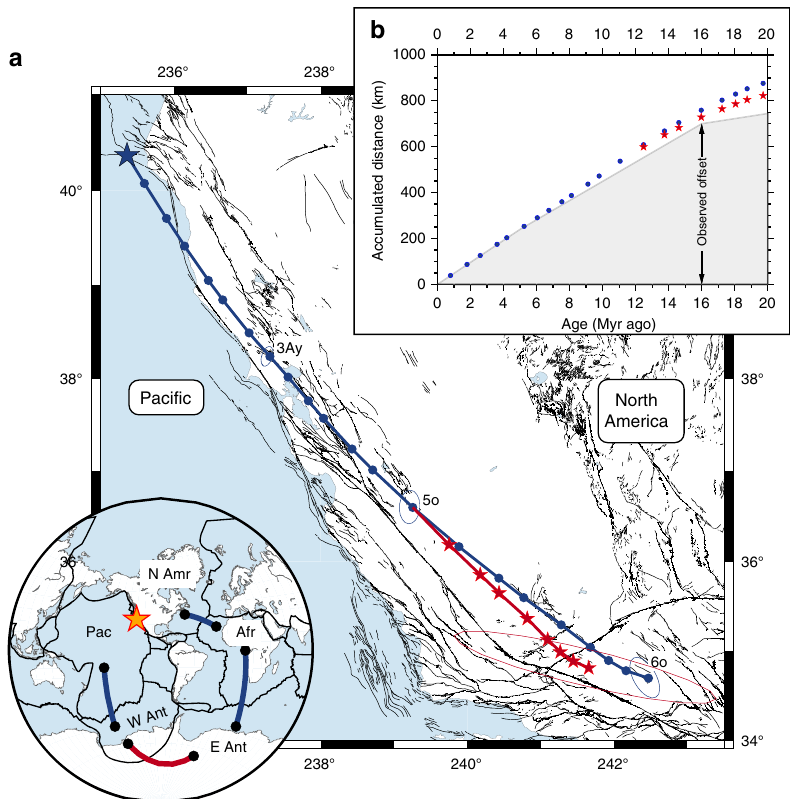
Fig. 7 Paci fi c-North America plate motions during the Neogene. a Predicted plate motion trajectory for the Paci fi c Plate relative to the North America Plate. The blue line shows the trajectory calculated by the summation of the noise-reduced Paci fi c-Antarctica-Africa-North America plate circuit rotations 12 , assuming that Antarctica was a single plate. Inclusion of East-West Antarctica motion between anomalies 8o and 5o (Table 1) results in the red trajectory. Ellipses show the resulting combined 95% uncertainty region for the reconstructed Mendocino Triple Junction (blue star). b Accumulated boundary- parallel displacement components (N40°W direction) calculated along the trajectories shown in panel a (blue and red stars were computed excluding and including, respectively, Neogene East-West Antarctica motion). Geological estimates of the boundary-parallel displacements across the plate boundary are shown by grey-shaded area (see Methods for (N40°W) offset younger than 16 Myr. Although prior deformation is not well resolved, we added 45km of deformation for the 20 to 16 Myr time period (Fig. 7) to account for early deformation in the Basin and Range and in faults located west of the San Andreas 51 . Data availability . The magnetic and fracture zone picks used to compute the kinematic models are available through the Global Sea fl oor Fabric and Magnetic Lineation (GSFML) repository 52 .